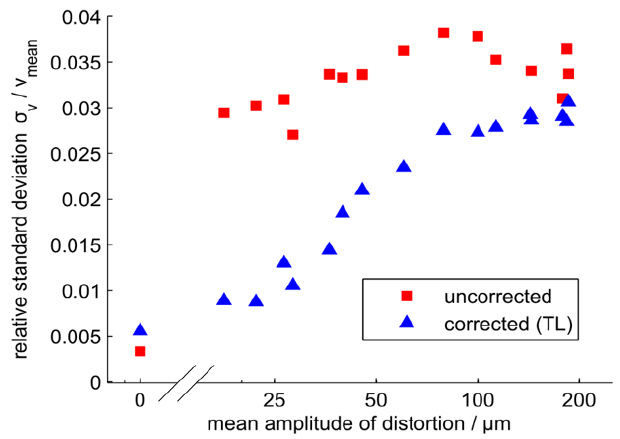
Figure 3. Relative standard deviation of the velocity measurement with and without distortion correction by the tunable lens (TL) as a function of the mean amplitude of the